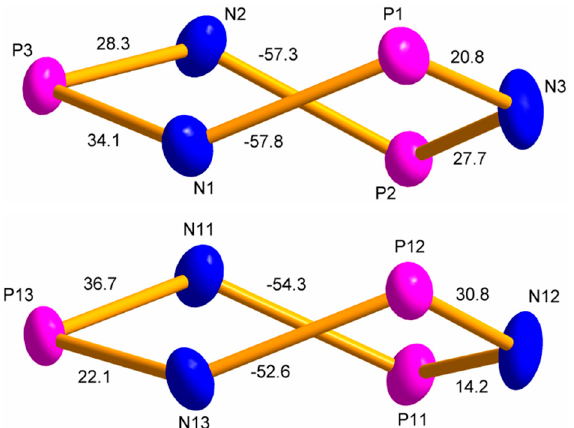
Figure 3. Side views of both P 3 N 3 rings with torsion angles (in °) highlighting the twist conformation.